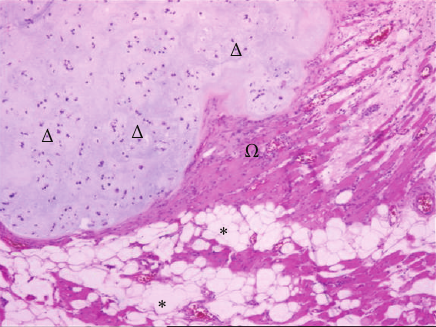
Figure 5: Hematoxylin-eosin stain with (x4) magnification. Aster- isk: adipose tissue, omega: muscle tissue, and delta: atypical chon- drocytes. Grade II